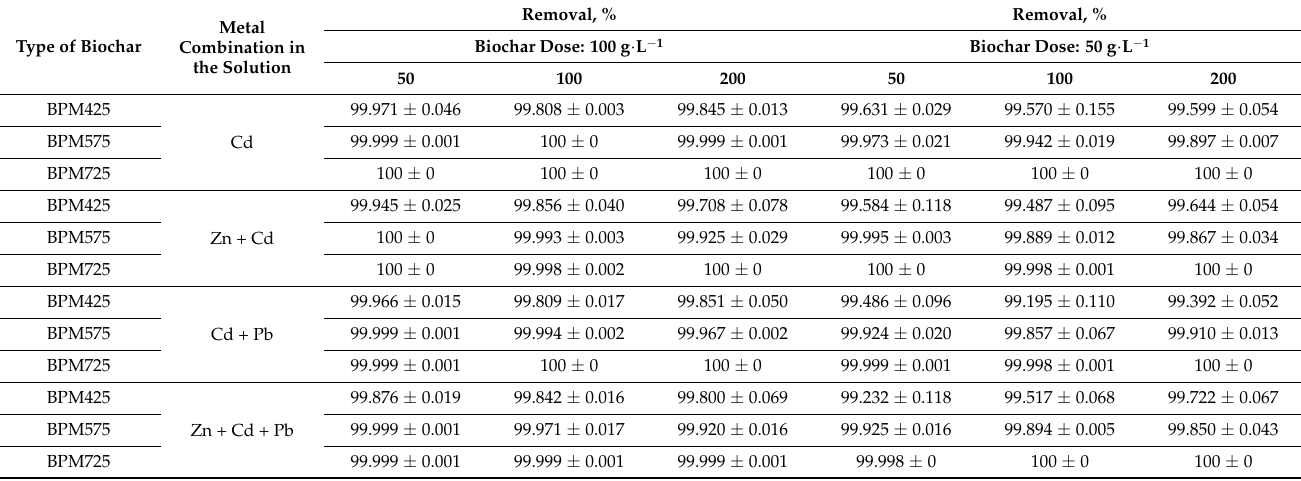
Table 9. Removal of Cd (%) from the solutions with mono-, double- and triple-metal combinations.